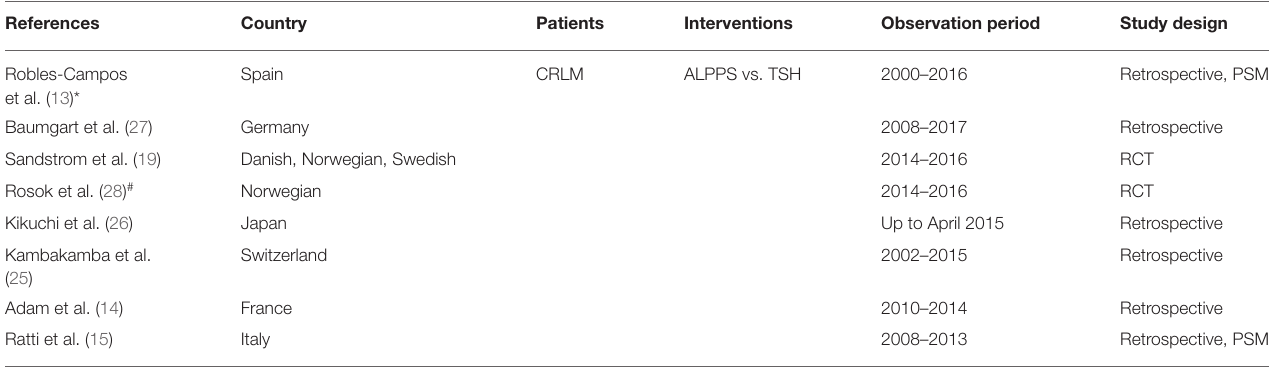
TABLE 1 | Characteristics of the included